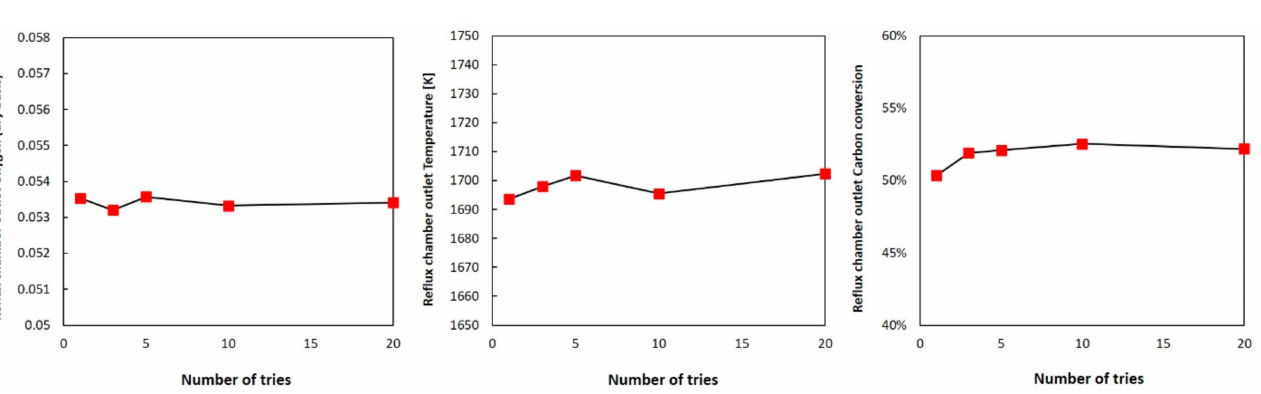
Figure 14. Predicted reflux chamber outlet values for different